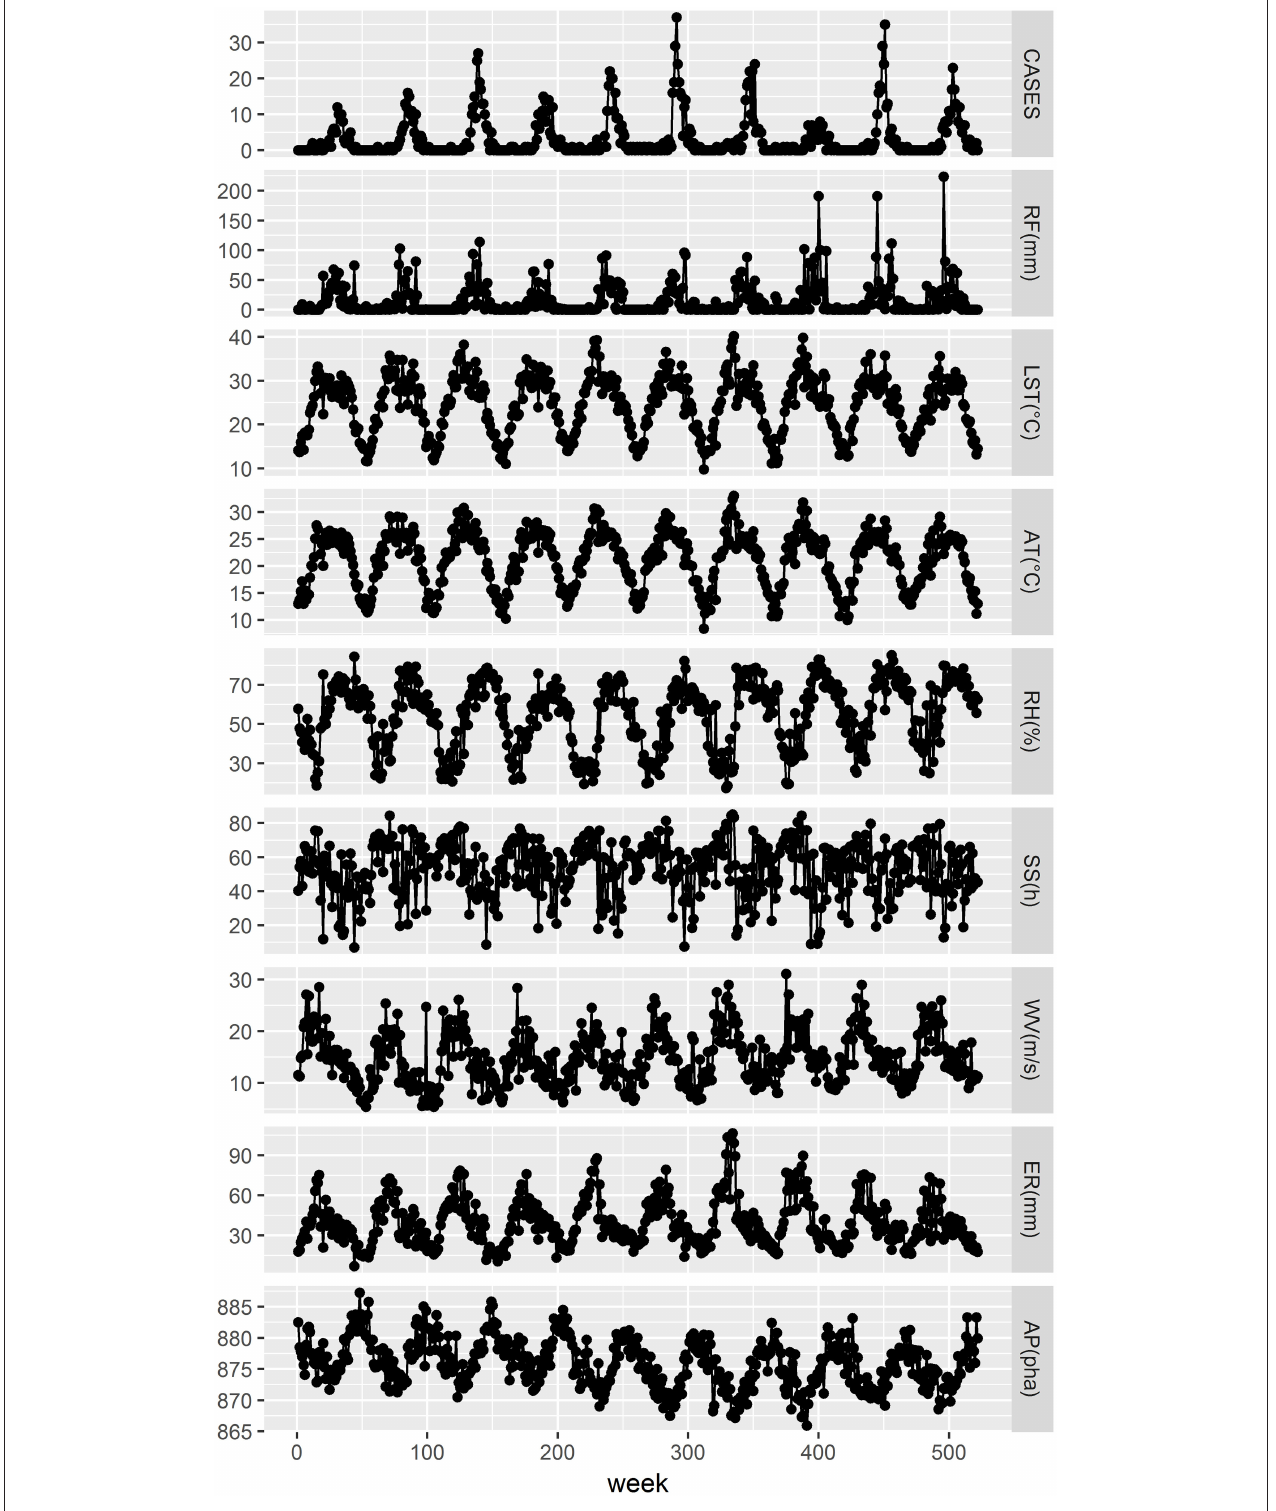
FIGURE 2 | Weekly time series of the number of scrub typhus cases and meteorological variables in rural areas of Panzhihua district, Southwest China, 2008–2017. RF, LST, AT, RH, SS, WV, ER, and AP represent the weekly values of aggregate rainfall, mean land surface temperature, mean air temperature, mean relative humidity, aggregate sunshine, mean wind velocity, mean evaporation, and mean air pressure, respectively.